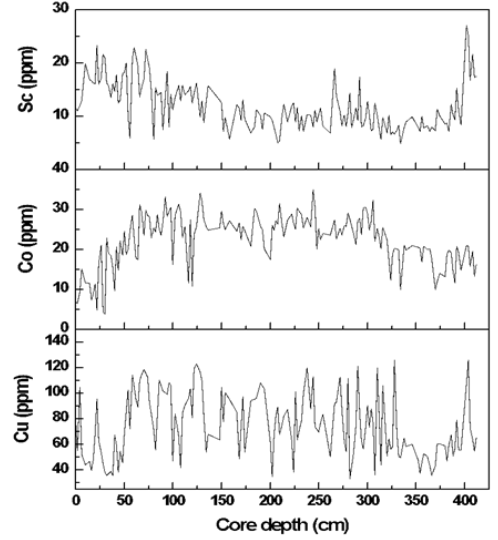
Figure 6: Down core variations of Cu, Co and